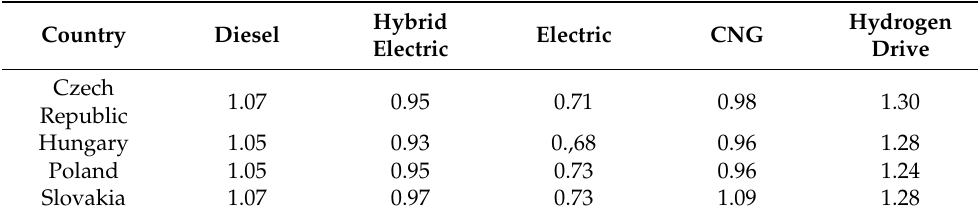
Table 14. Cost of a vehicle-kilometer of maxi buses (12 m) with different drive types in the V4 countries, calculated on the basis of the first year of operation (2021) ( € ). Country